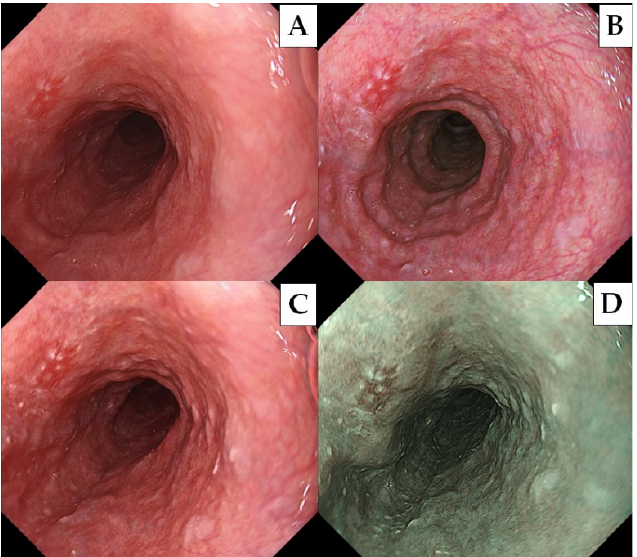
Figure 2. A demonstrative case of superficial esophageal cancer. The lesion was observed by ( A ) WLI, ( B ) TXI mode1, ( C ) TXI mode 2, and ( D ) NBI. The histology obtained from the endoscopic submucosal dissection revealed squamous cell carcinoma invading the lamina propria mucosa.